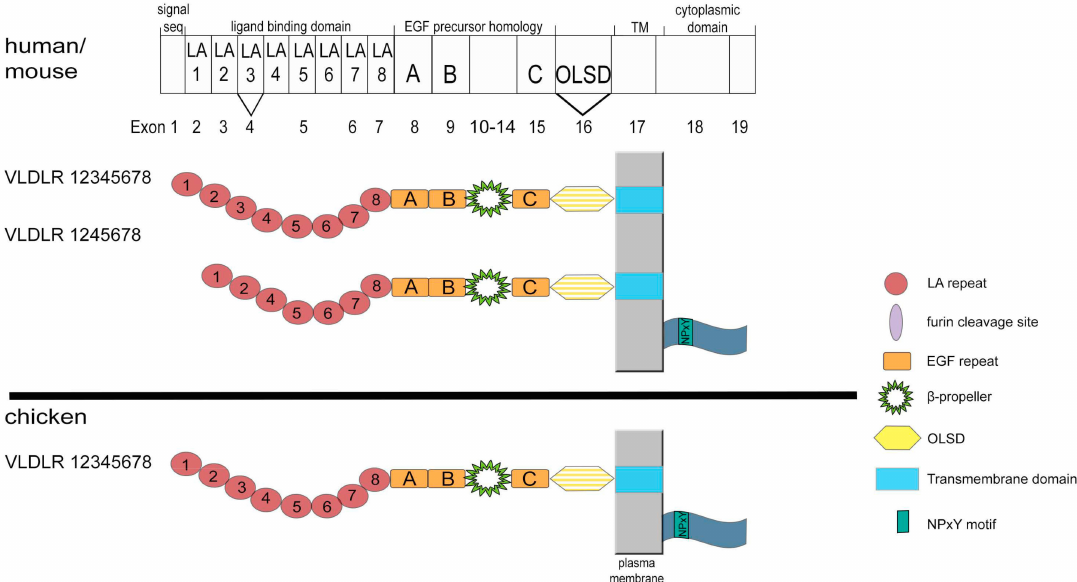
Figure 3. VLDLR variants present in human, mouse, and chicken. VLDLR transcript/exon organizations for human and mouse are presented as rectangular bar with exon numbers noted below. Corresponding protein domains are depicted inside the boxes (LDL receptor type A repeats, LA; epidermal growth factor precursor-like repeats, A–C; O -linked sugar domain, OLSD). Structural domains which are not corresponding to single exons are delineated above the rectangular bar (transmembrane domain; TM). Alternatively spliced exons are indicated by V. Domain-structures of the corresponding proteins are shown below the gene structure. Hatched domains can be deleted from receptor variants by alternative splicing. Domains are not drawn to